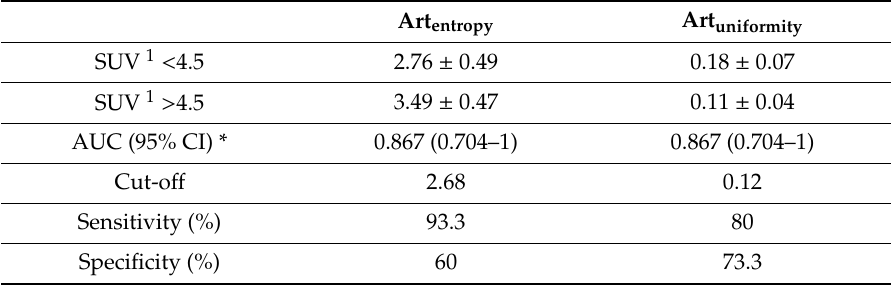
Table 4. One-way ANOVA and ROC tests on Art entropy and Art uniformity for the identification of high SUV